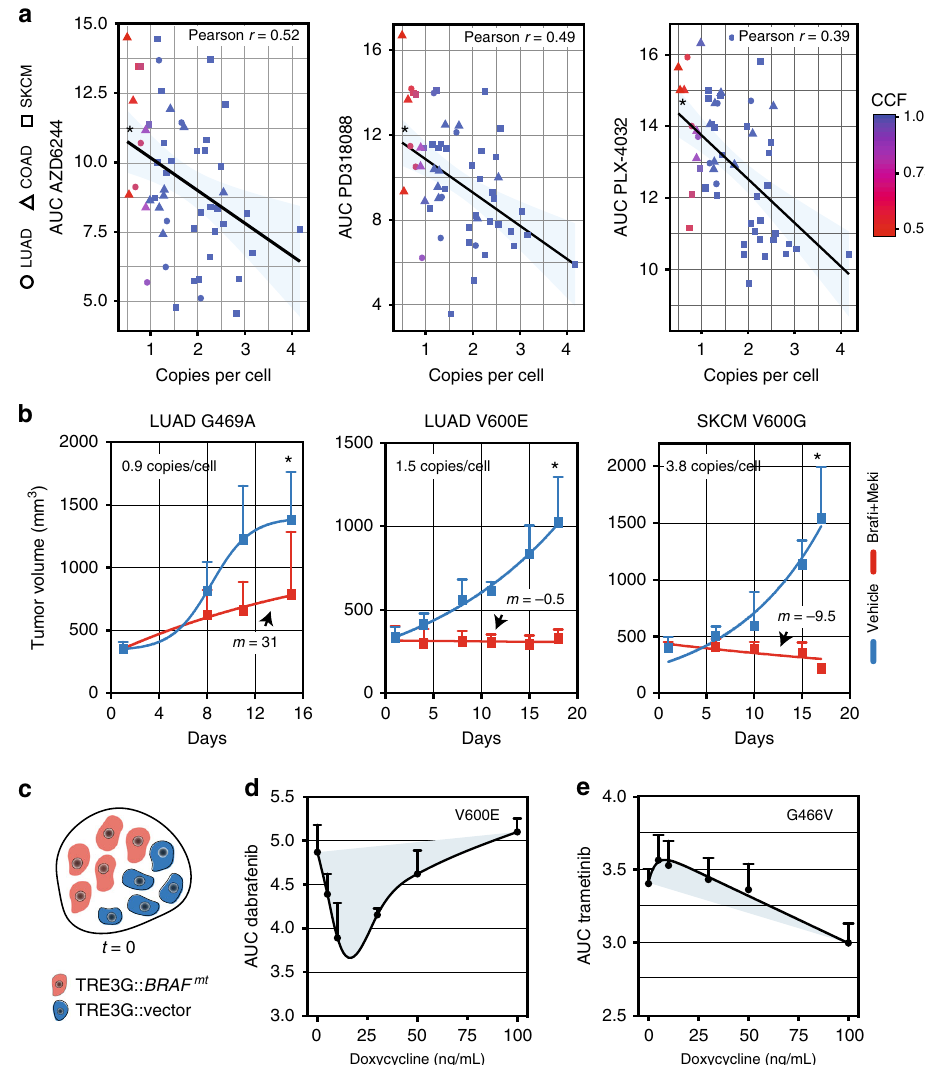
Fig. 5 BRAF -variant identity and multiplicity regulates tumor responses to targeted therapies. a Cells with higher BRAF variants copies per cell (and higher CCF) were more sensitive to MEK1/2 (AZD6244 or PD318088) or BRAF (PLX-4032) inhibition. AUC, area under the curve. CCF values for individual cells are designated by the heatmap. b NSG mice bearing PDX with the indicated BRAF mutation and copies per cell were treated with dabrafenib (BRAFi) and trametinib (MEKi). Data are expressed as the mean ± s.d. The P -value of the χ 2-test between the control and treatment groups was <0.05, <0.001, <0.0001. c Schematic depicting the co-culturing of cells expressing BRAF V600E or BRAF G466V and vector alone. After 48 of Dox-induction, cells were treated with either d dabrafenib (BRAFi) or e trametinib (MEKi). Cellular survival was measured 5 days after drug treatment. Data are expressed as the area under the curve (AUC) and represent the mean ± s.e.m. of at least three independent